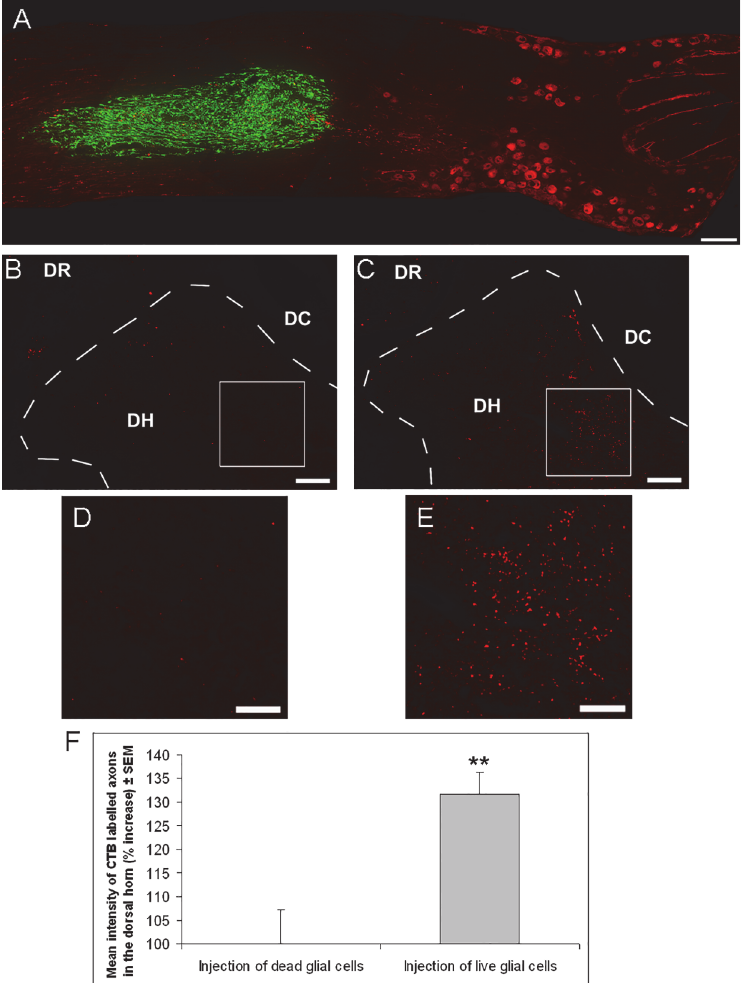
Fig 2. Transplantation of retinal glia significantly enhances DRG axon regeneration past the dorsal root entry zone. (A) Composite photomicrograph showing GFP+ retinal glia (green) that had been transplanted two weeks earlier 1 – 2 mm distally to CTB labelled L5 DRG neurons (red) into the spinal nerve side in an adult rat. (B,C) Low magnification images, of the dorsal root (DR), dorsal horn (DH) and dorsal column (DC) and (D,E) high magnification images of the dorsal horn, showing CTB labelled DRG axons, after transplantation of (B,D) dead retinal glia or (C,E) live retinal glia. (F) Quantification of the percentage increase in intensity of CTB labelled axons in the dorsal horn after transplantation of dead or live retinal glia in adult rats (n = 7 rats, dead glia; n = 8 rats, live glia). Animals in A-F were sacrificed two weeks after surgery. Significant differences are indicated by asterisk (P < 0.01 = ** ). Scale bars: (A) 200 μ m; (B,C) 100 μ m; (D,E) 50 μ